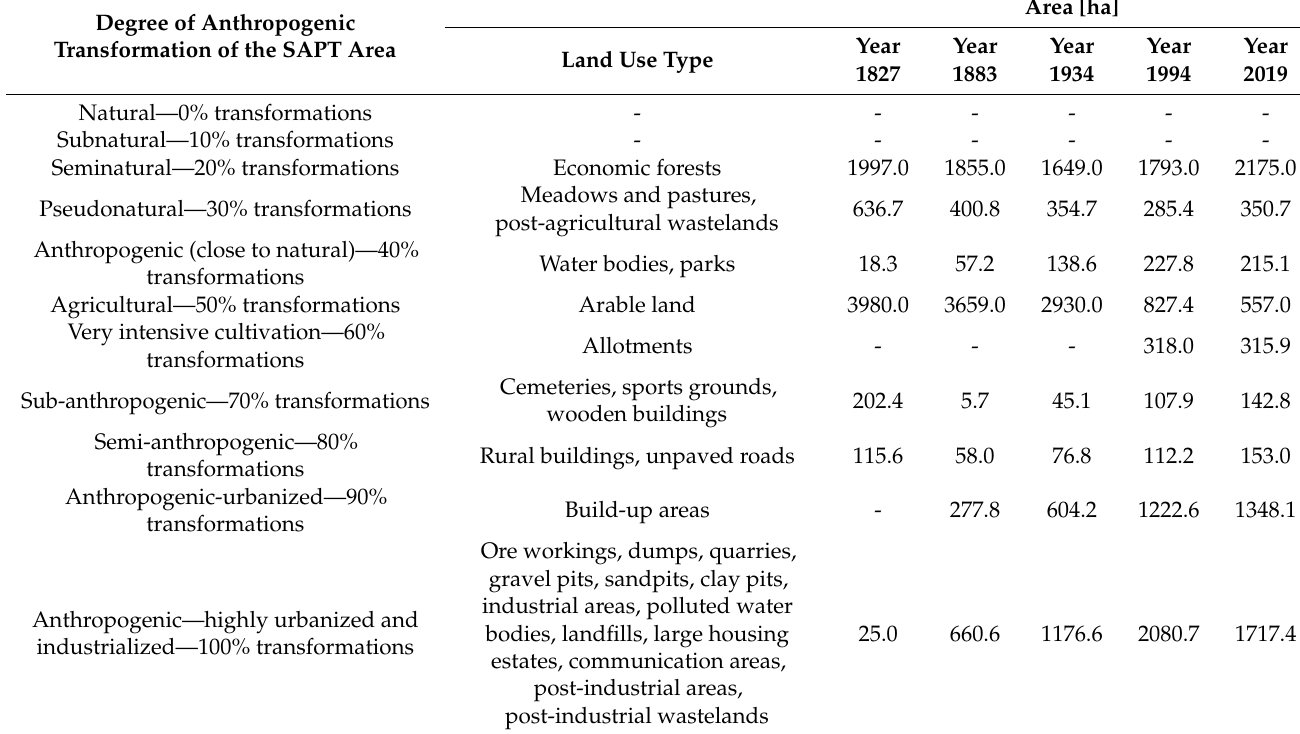
Table 2. Changes in the Degree of Anthropogenic Transformation of the Bytom Area in